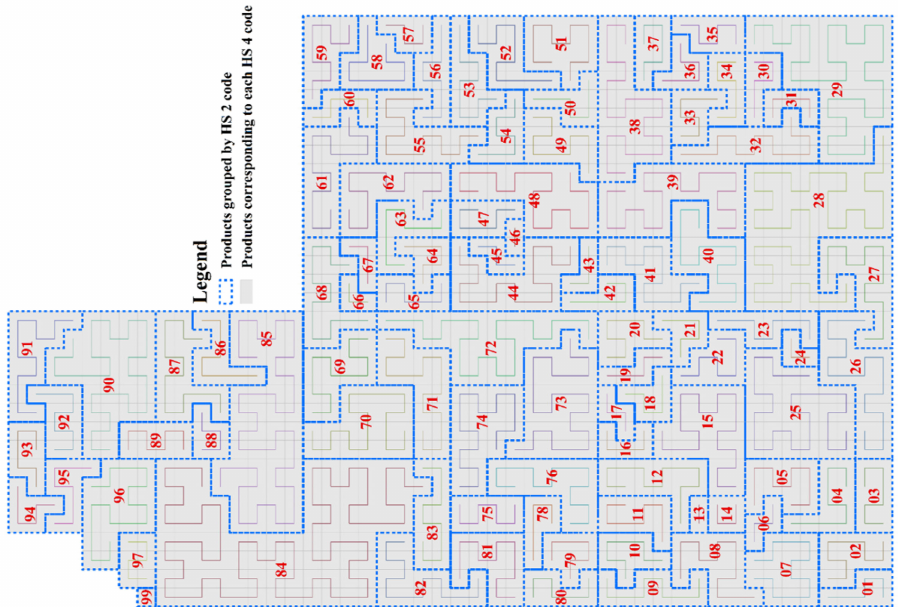
Figure 4. HS 4-digit code grid system. Each type of HS 4-digit code product corresponds to one grid, and the marked number is the HS 2-digit code of the product category to which it belongs. See Figure A2 for details of the HS 6-digit code grid